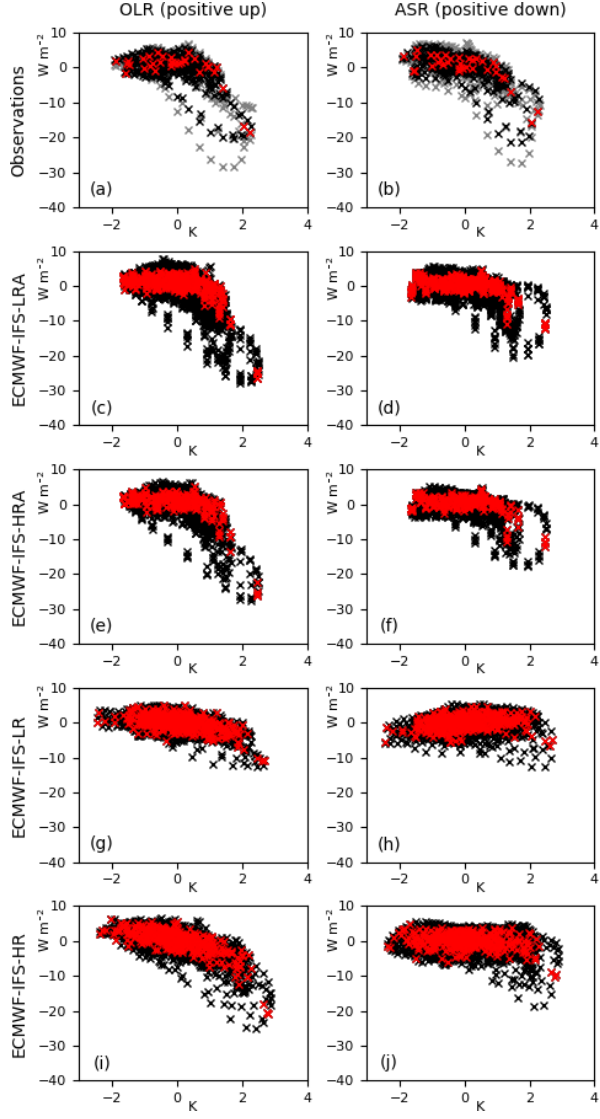
Figure 17. Scatter plots of SST anomalies from Niño3.4 region against anomalies of top-of-atmosphere outgoing long-wave radia- tion (OLR) and top-of-atmosphere absorbed solar radiation (ASR). Observation-based estimates are from a composite of satellite ra- diation products (black crosses; Mayer et al., 2016) and the ERA- Interim reanalysis (grey crosses; Dee et al., 2011). ECMWF-IFS data are for all available HighResMIP experiments and ensemble members. Data are monthly anomalies relative to the 1981–2010 seasonal cycle, and all values are smoothed using a 13-point bi- nomial filter prior to plotting. Black crosses represent all monthly values and red crosses are December values, when ENSO-related anomalies are usually strongest.